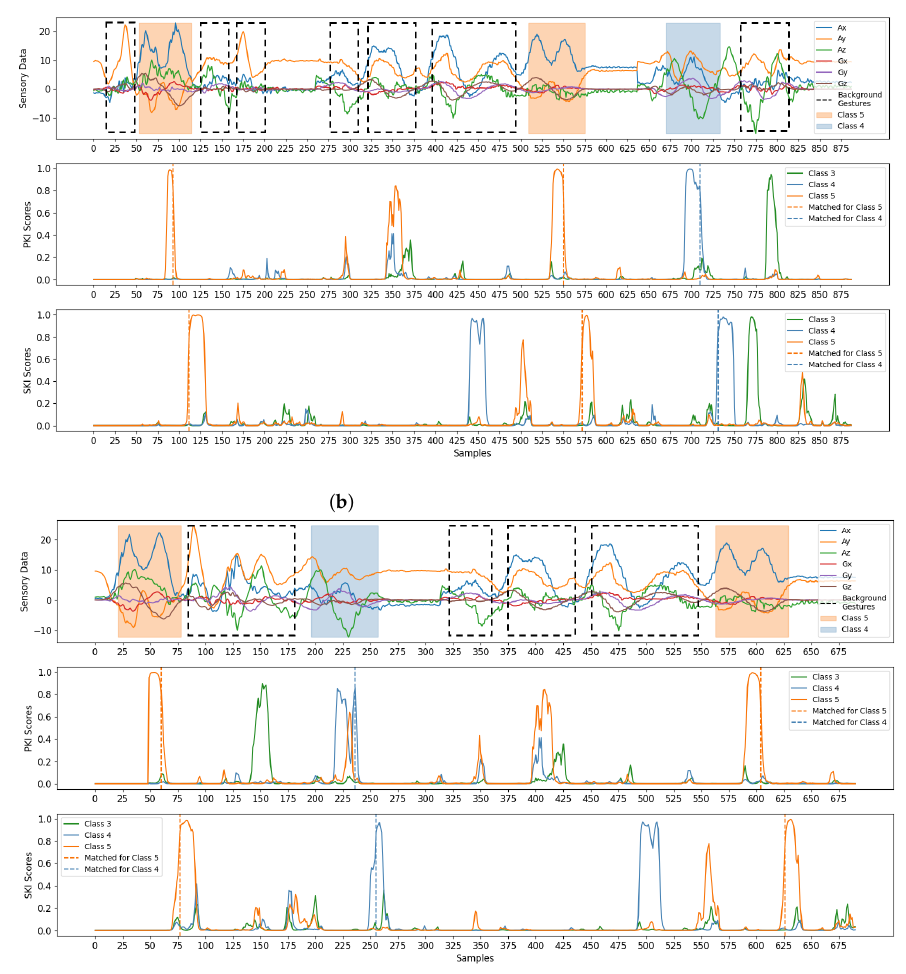
Figure 10. Examples for the detection and classification of the proposed algorithm. There are three test sequences considered in the example. Each sequence is a mixture of foreground ges- tures and background samples/gestures. The foreground gestures and background gestures are marked by coloured and dotted blocks, respectively. The PKI or SKI scores resulting in matched detections are marked by dotted lines. Each foreground gesture results in a pair of matched detec- tions for PKI and SKI. Therefore, we are able to detect all the foreground gestures in the examples, ( a ) Example 1, ( b ) Example 2, ( c ) Example